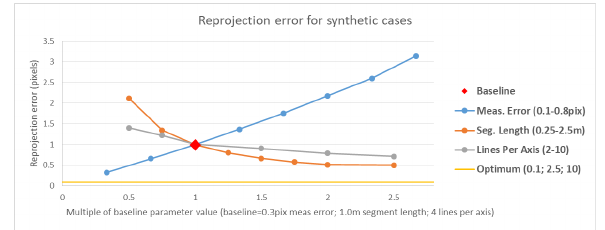
Figure 5. 1000 reprojections using Monte Carlo perturbations of the baseline model. The grid lines are individual pixels. The ellipses are 1 σ , 2 σ , and 3 σ ellipses for covariance matrix (7). Figure 6 presents the effect on reprojection error of these devi- ations from the baseline setup. Three different error response curves are presented with a unified X axis, which indicates the multiple of the baseline value that is used for the corresponding parameter. The baseline case is indicated at the intersection of the three curves (all three parameters at 1 . 0 × baseline).